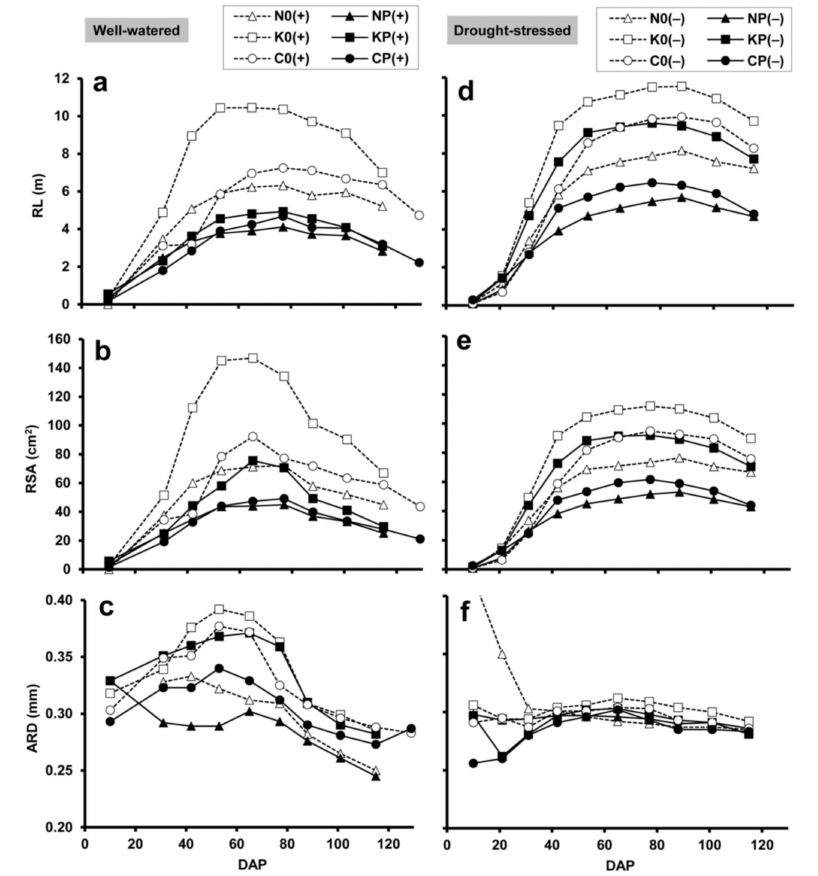
Figure 2. ( a , d ) Root length (RL), ( b , e ) root surface area (RSA) and ( c , f ) average root diameter (ARD), obtained by minirhizotron image analysis, in relation to plant age (DAP: days after planting) under well-watered ( a – c ) and drought-stressed ( d – f ) conditions. RL and RSA are sums from the three soil depths (20, 50 and 80 cm), ARD is a weighted average. For treatment codes, see Figure 1. Under drought conditions, there was a prolonged increment in total RL and RSA until DAP 77 or 88 (milky or dough stages; BBCH 75–85), followed by a slight decline